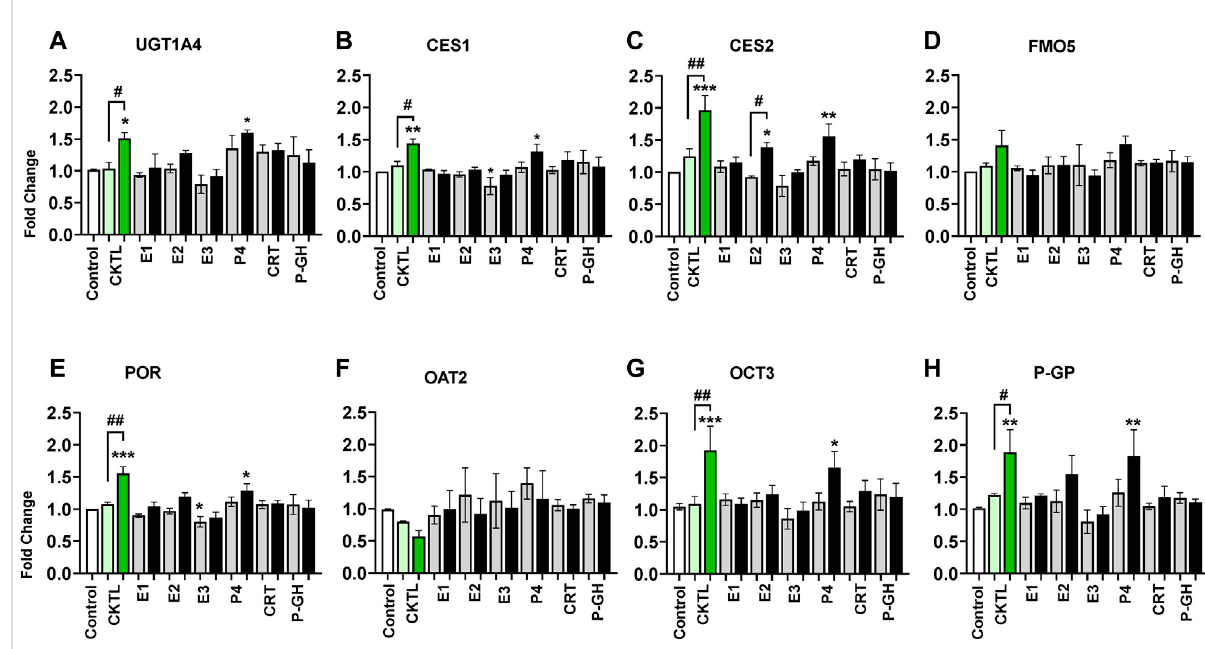
FIGURE 7 Impact of individual pregnancy related hormones (iPRHs) on DME and transport protein concentrations in SCHH. Human hepatocytes from three quali fi ed donors (Hu8373, Hu8375, and Hu1970) were exposed to vehicle control, PRH cocktails (CKTL), or the iPRHs E1, E2, E3, P4, CRT, or pGH that target average trimester 3 (transparent bar) or supraphysiological 10-fold T3 (solid bar) PRH concentrations. The bar graphs represent mean ± SEM fold-change for UGT1A4 (A) , CES1 (B) , CES2 (C) , FMO5 (D) , POR (E) , OAT2 (F) , OCT3 (G) , and P-GP (H) (proteins that were signi fi cantly altered by PRH cocktails in Figures 4 – 6) relative to control across donors in response to the PRH CKTL or iPRHs ( n = 3 per group). p < 0.05, ** p < 0.01, *** p < 0.001 versus control. #Represents concentration-dependent effect across PRH groups (# < 0.05, ## <